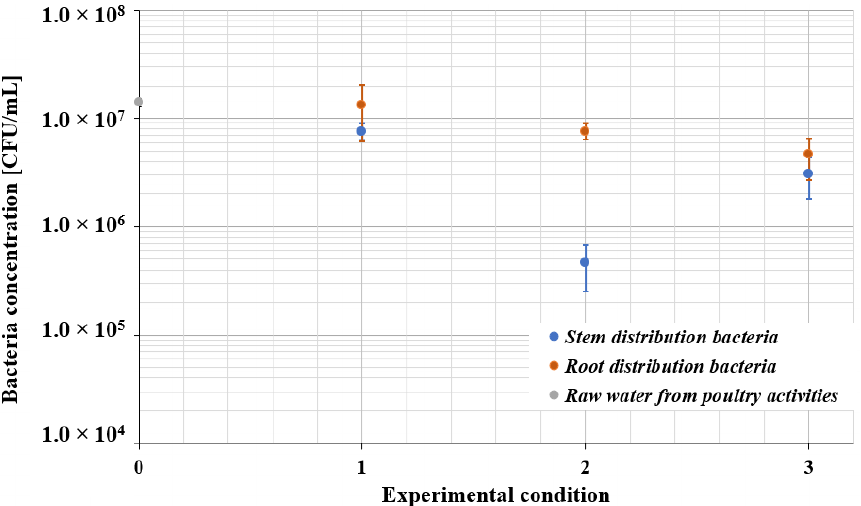
Figure 5. Internalization of S. typhimurium bacteria in lentil structures. Experimental condition: (0) raw wastewater from poultry activities, (1) without application of a treatment, (2) direct application of NTP to plants irrigated previously with wastewater from poultry activities, and (3) activation of raw wastewater used for irrigation of seeds.